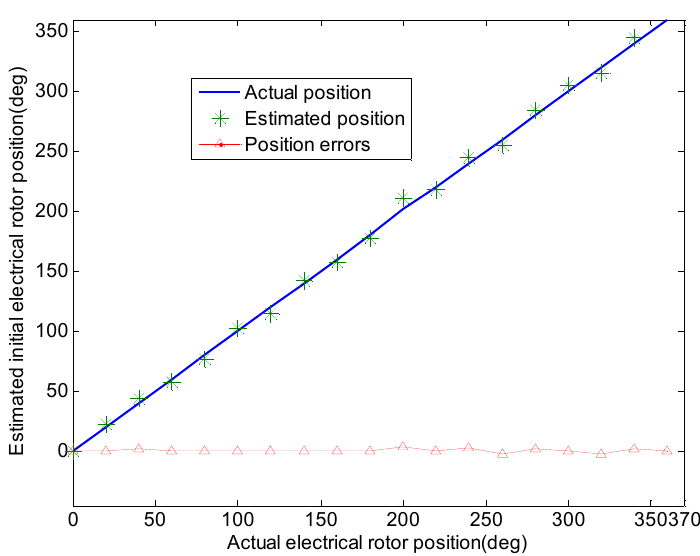
Figure 17. Experimental results of initial electrical rotor position estimation.